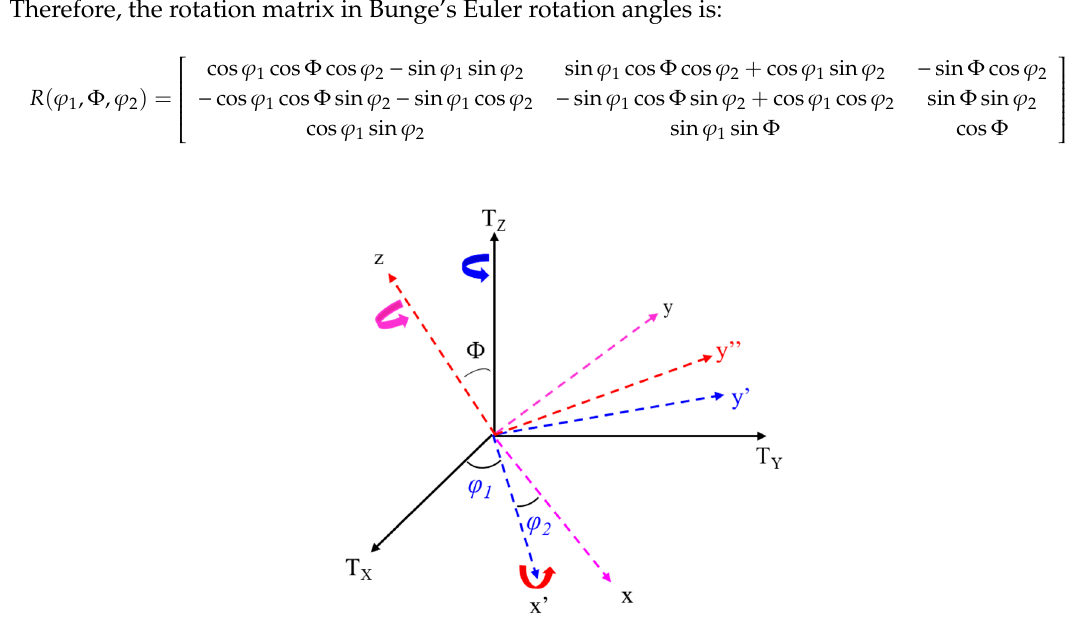
Figure 1. The orientation of the crystallite coordinate ( x , y , z ) in the texture coordinate system ( Tx , Ty , Tz ).